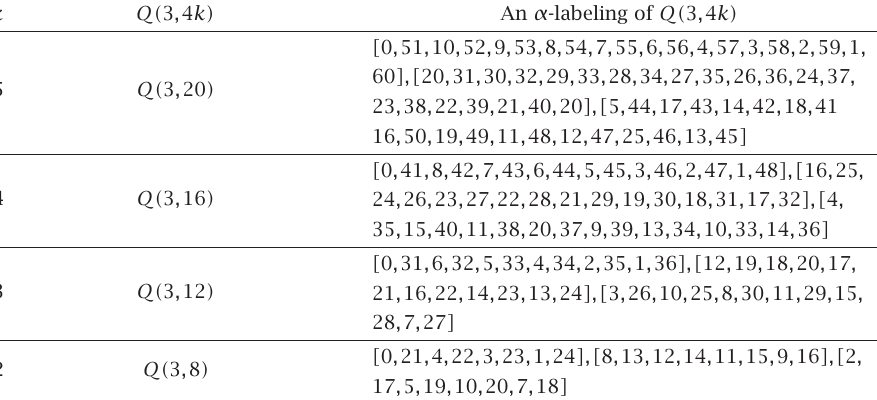
Table 2.1 . An α -labeling of Q( 3 , 4 k) for 2 ≤ k ≤